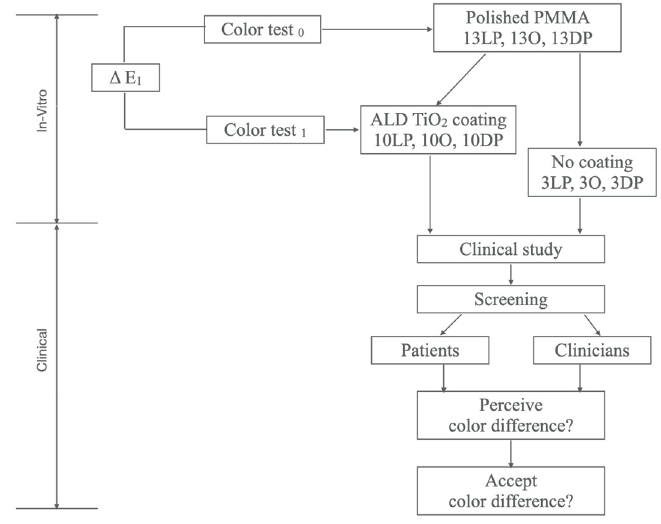
Figure 1. Schematic of study design used.